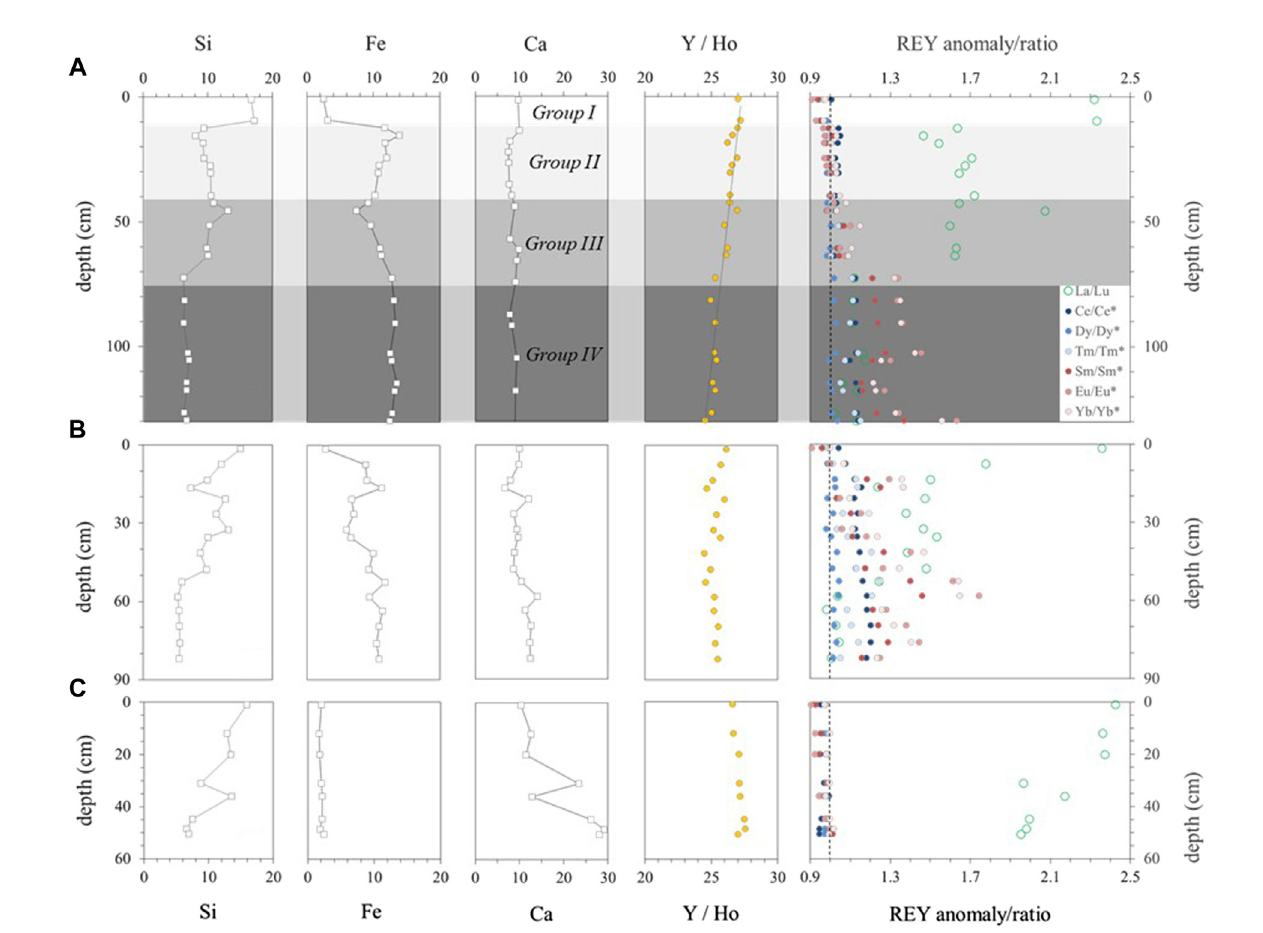
FIGURE 3 Evolution with depth of Si, Fe and Ca contents, as atomic percentage, and the REY pattern characteristics observed in the core collected from the Orne Riverbank at (A) BETHUP, (B) JOEP and (C) JOSAN sampling locations. REY anomalies and ratios are calculated using the Aalenian calcareous sandstone- normalized